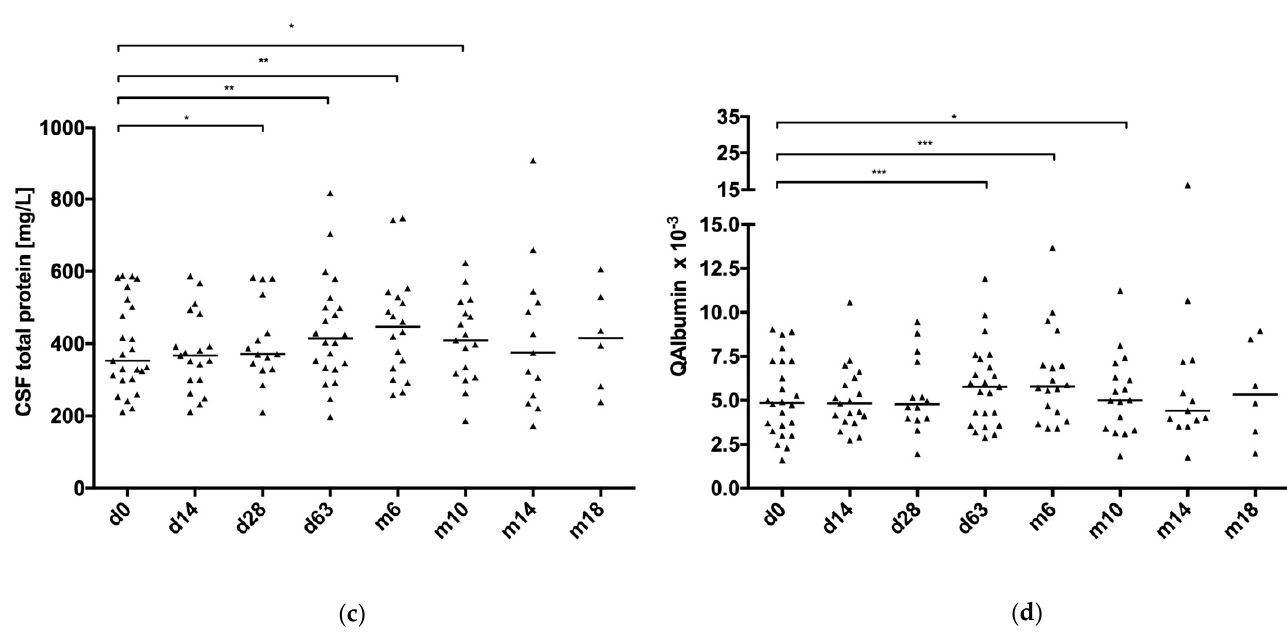
Figure 1. CSF routine parameters during nusinersen therapy (d0 to m18). ( a ) CSF leukocyte count and lactate, ( b ) CSF lactate, ( c ) CSF total protein, and ( d ) QAlbumin. Values displayed as scatter plots with the median. CSF: cerebrospinal fluid; d: day; m: month; QAlbumin: CSF/serum albumin quotient. *: p ≤ 0.05; **: p ≤ 0.01; ***: p ≤ 0.001.